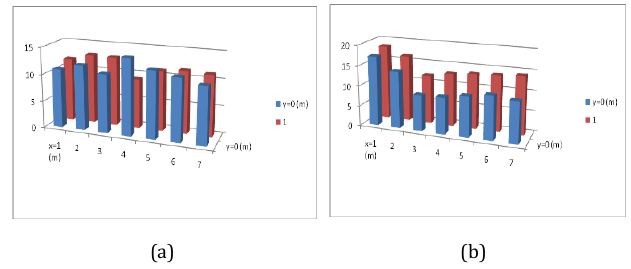
Figure 7: Electrical potential distribution (in mV) on the survey area using Cu/CuSO4 porous pots: (a) without leakage and (b) with leakage.